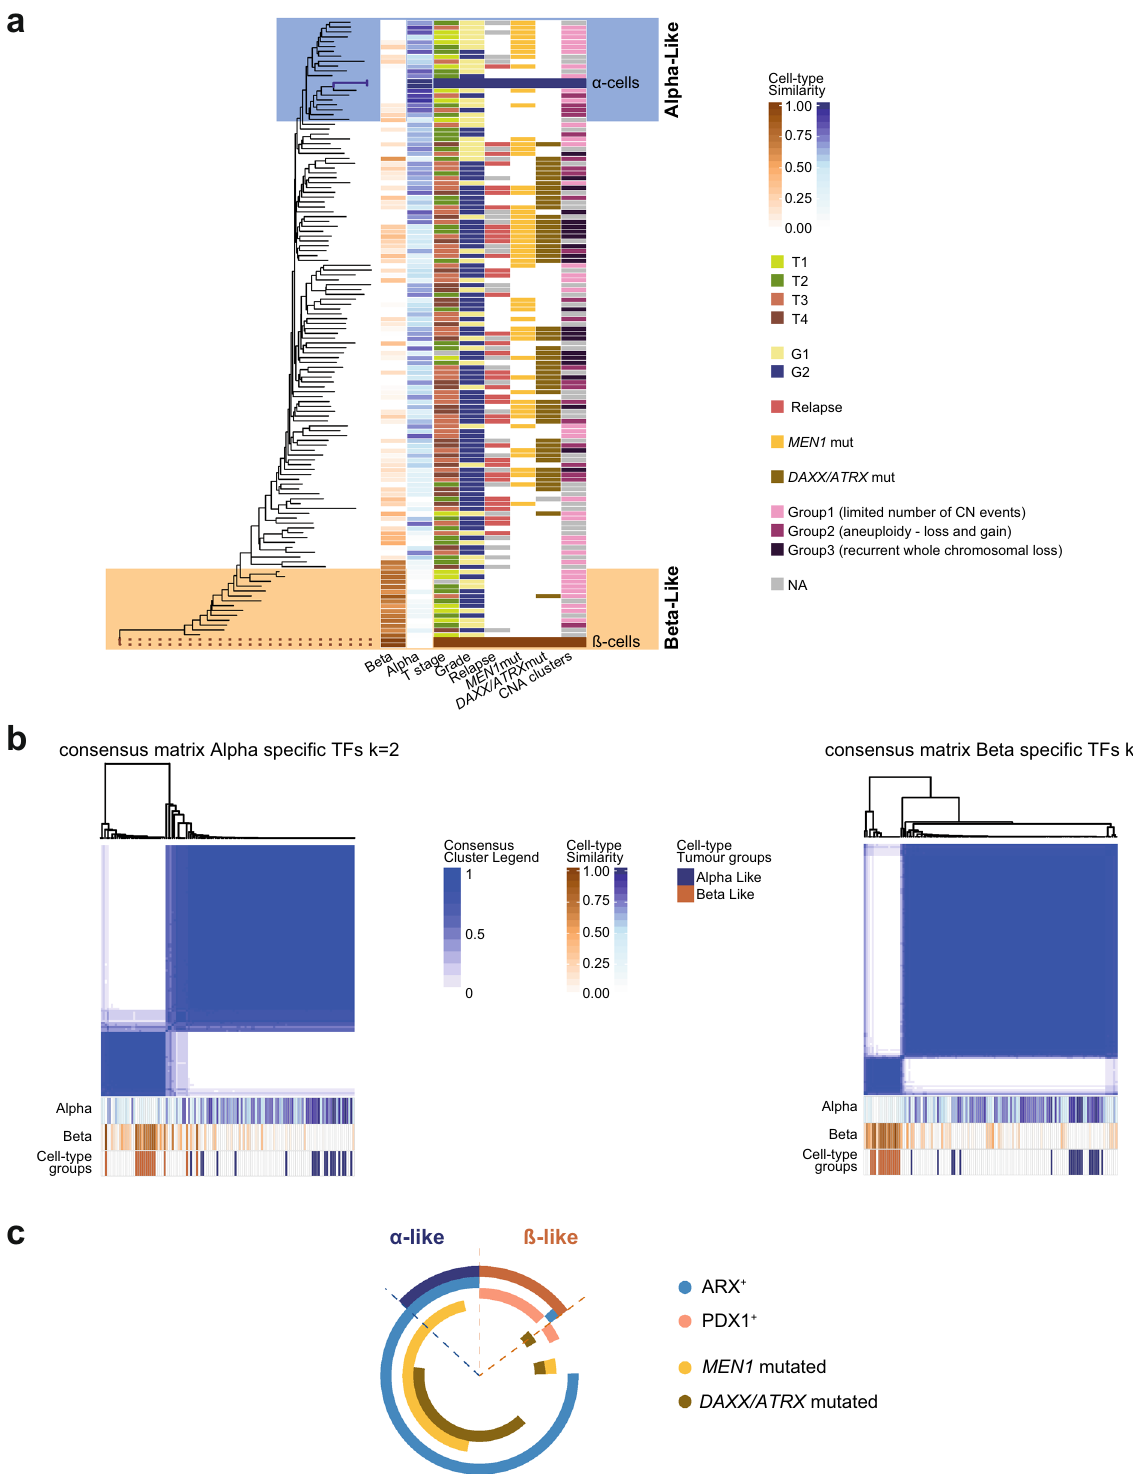
DNA-methylation table (including the values of methylation for 363,665 CpG sites and 125 samples). Phyloepigenetic analysis of the 2131 identi fi ed CpG sites using either normal β - or normal α - cells as roots, indicated clear hierarchical relationships between normal cells and tumour specimens (Fig. 1a, Supplementary Fig. 2a). We de fi ned PanNETs that grouped together with normal α - or β -cells as α -like or β -like PanNETs, respectively (Fig. 1a and